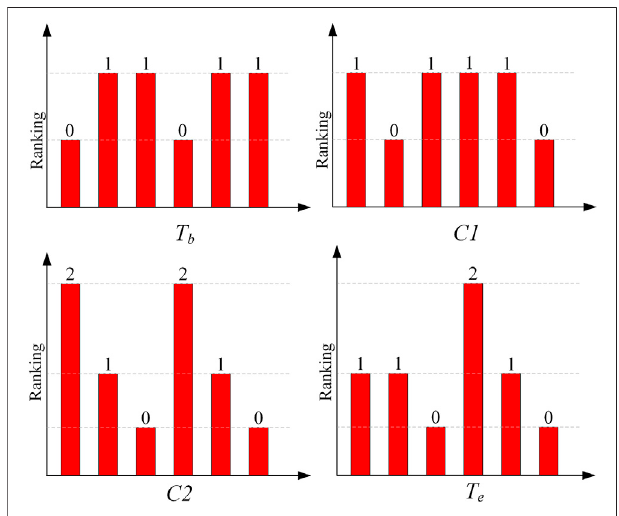
FIGURE 8 | Defect code diagram of electrical continuity loss of cable sheath in horizontal